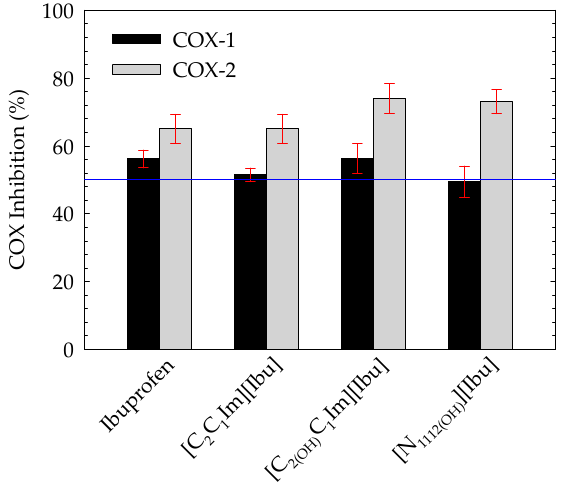
Figure 4. Selective inhibition of COX-1 and COX-2 enzymes for ibuprofen and ibuprofen-based ILs at 3 mM. The YY axis guideline corresponds to 50% COX inhibition. Table 6. Inhibition of COX-1 (ovine) and COX-2 (human) and COX-1/COX-2 selectivity for 3